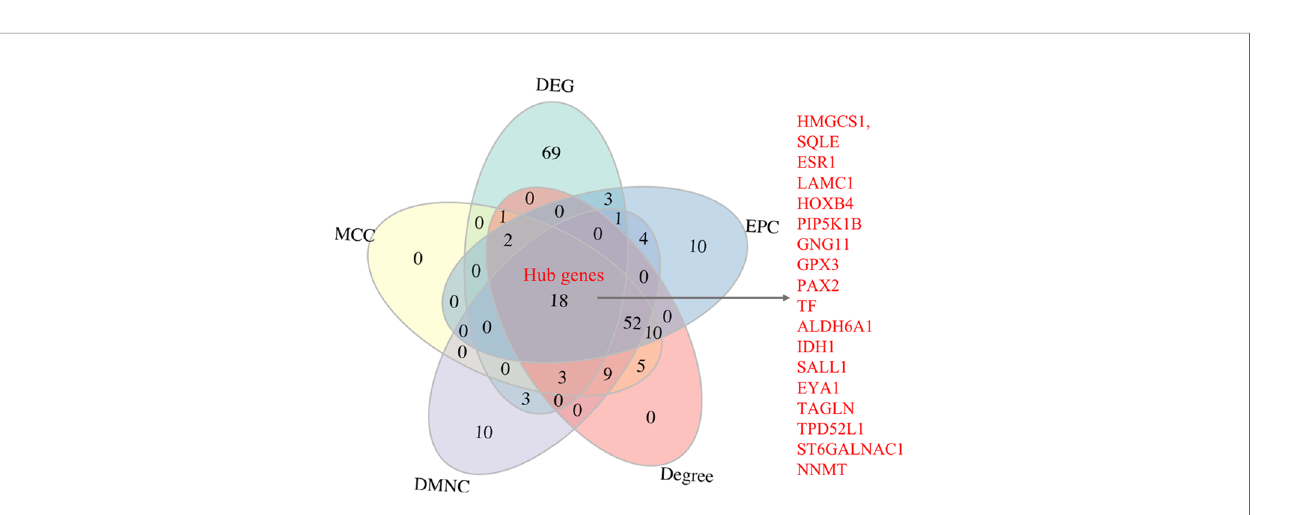
FIGURE 5 | Venn plot showing the intersection of the hub